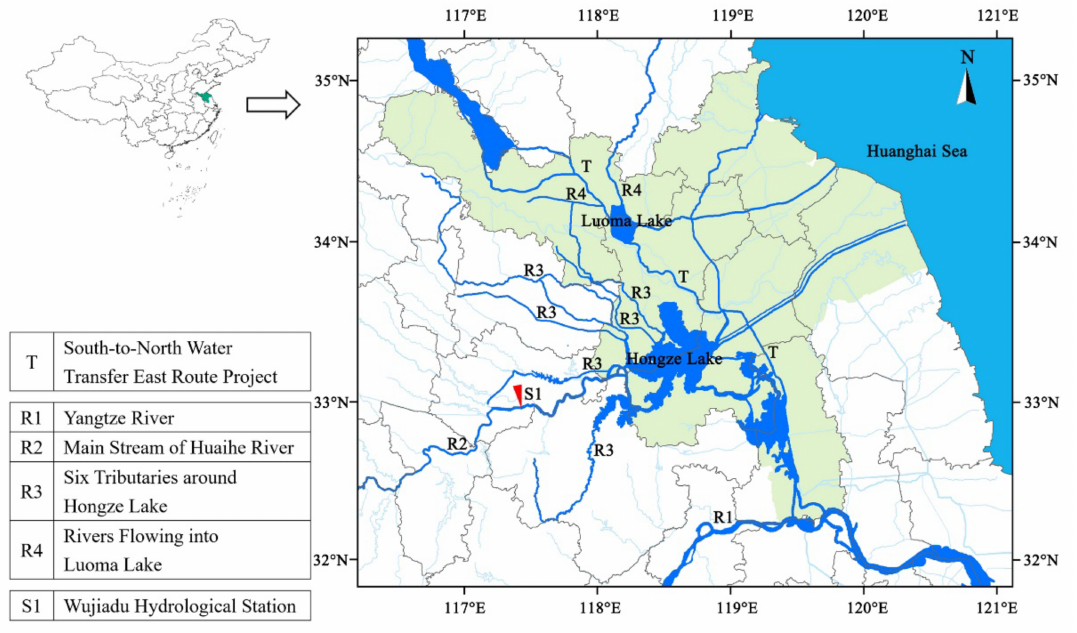
Figure 1. Map of the study